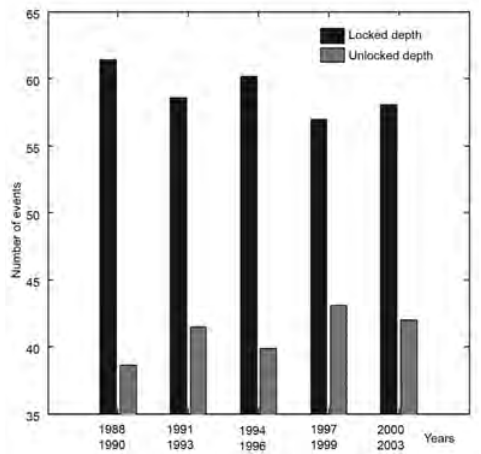
Fig. 11. Percentage of the events whose hypocen- tral location has fixed (darker) depth. The percenta- ges are calculated over a three year period, as indica- ted on the abscissa.